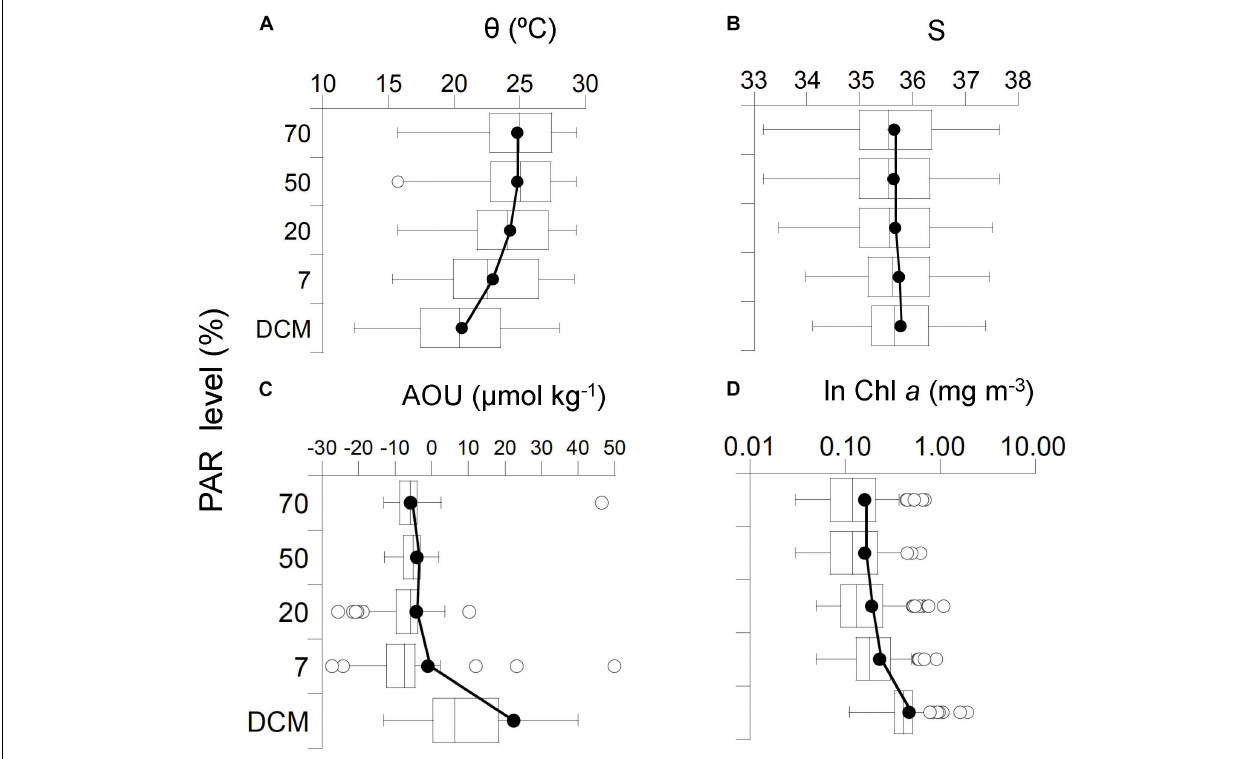
FIGURE 6 | Box and Whisker plots representing average global distribution among the photic layer (five nominal depths) of the physical, chemical and biological explanatory variables: (A) Potential temperature θ , (B) Salinity S, (C) Apparent oxygen utilization AOU, and (D) Chlorophyll a . Note that Chl a was ln-transformed. Horizontal line represents median; black circles represent means; white-box represent 25–75% percentiles and whiskers extend from the upper (lower) to the highest (lowest) value that is within 1.5x inter-quartile range of the hinge. Solid black line connects global mean values within the photic layer.